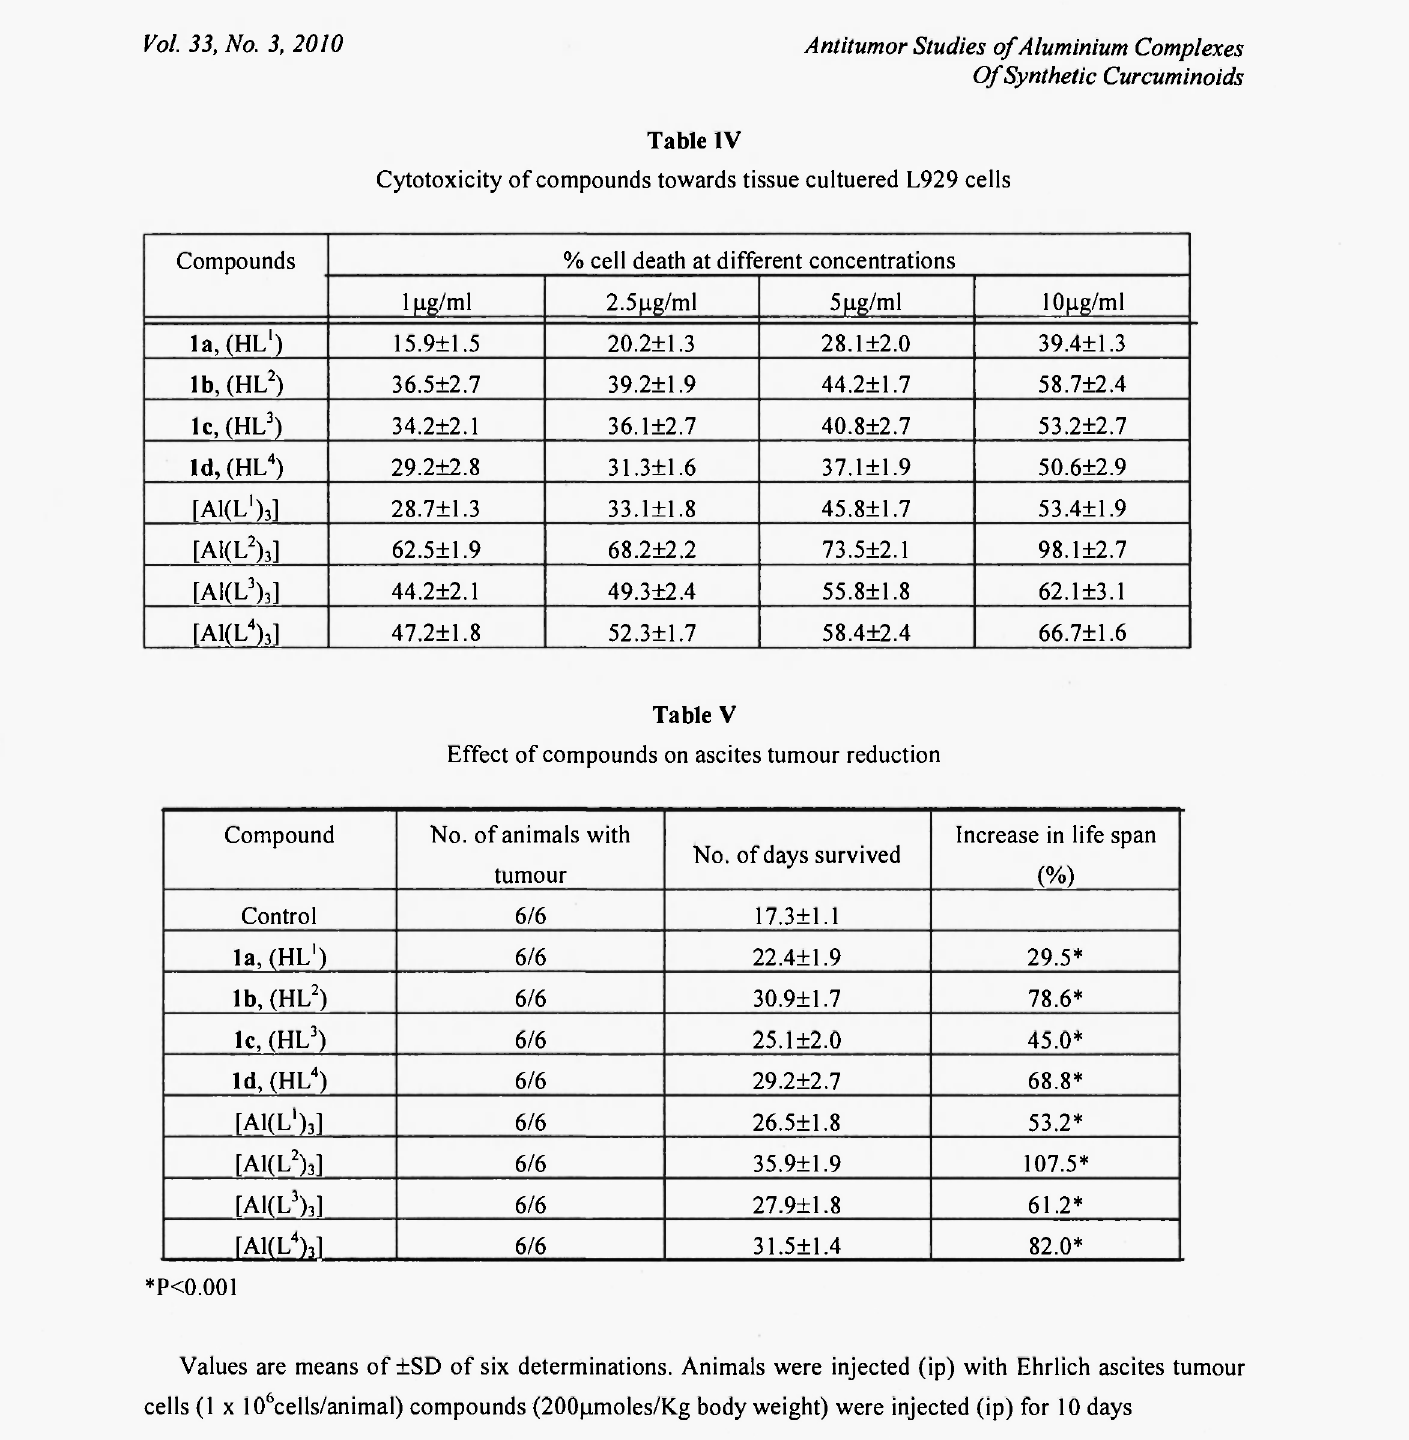
Cytotoxicity of compounds towards tissue cultuered L929 cells